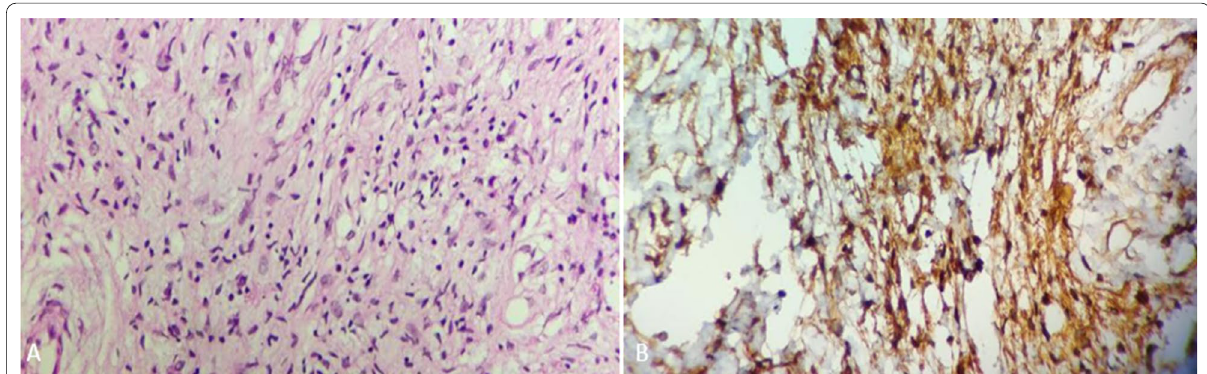
Fig. 6 Photomicrograph of the biopsy sample performed from the perinephric soft tissue infiltrates in a 60-year-old male patient with Erdheim– Chester disease reveals collection of histiocytes with abundant foamy cytoplasm and associated with minimal lympho-plasmacytic infiltrates on high power (100 ) ( A ). Immunohistochemistry staining for CD-68 reveals histiocytes positive for CD-68 cells ( B ×